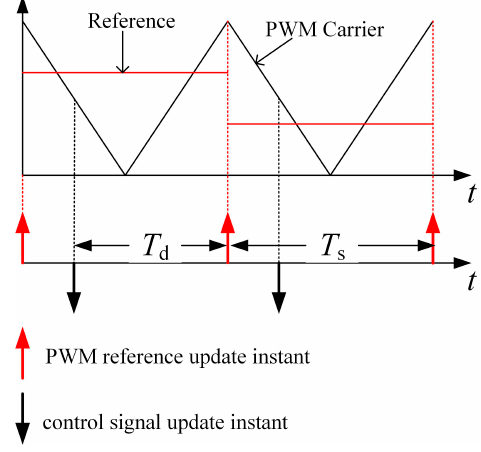
Figure 3. Delay mechanism in the digital control.